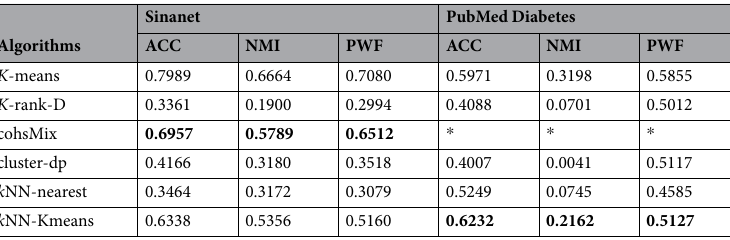
Table 9. Performance of compared algorithms on Sinanet and PubMed